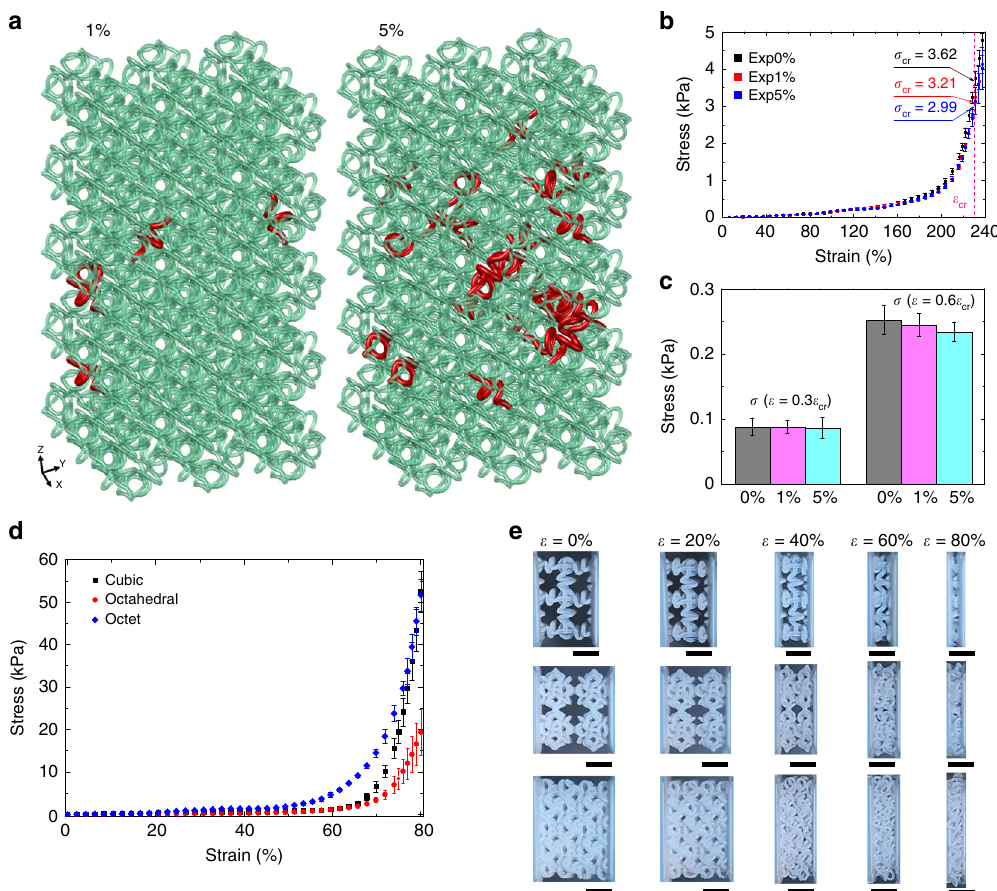
Fig. 4 Stress – strain curves in the presence of random defects or under uniaxial compression. a Visualization the randomly distributed defects (i.e., missing microstructures) in soft octahedral network materials with two typical defect densities (1% and 5%). b J-shaped stress – strain curves of soft octahedral network materials with 0%, 1%, and 5% random defects. For each level of defect density, at least three samples with different distributions of random defects are taken into account. c In fl uence of the randomly distributed defects on the effective critical stress. d Measured stress – strain curves under uniaxial compression, for soft 3D network materials with three different topologies (cubic, octahedral, and octet). All of the structures consist of 2 × 2 × 2 unit cells and the same helical microstructures as those in Fig. 2. e Optical images of the three soft network structures under different levels of uniaxial compression. Scale bars, 5 mm in e